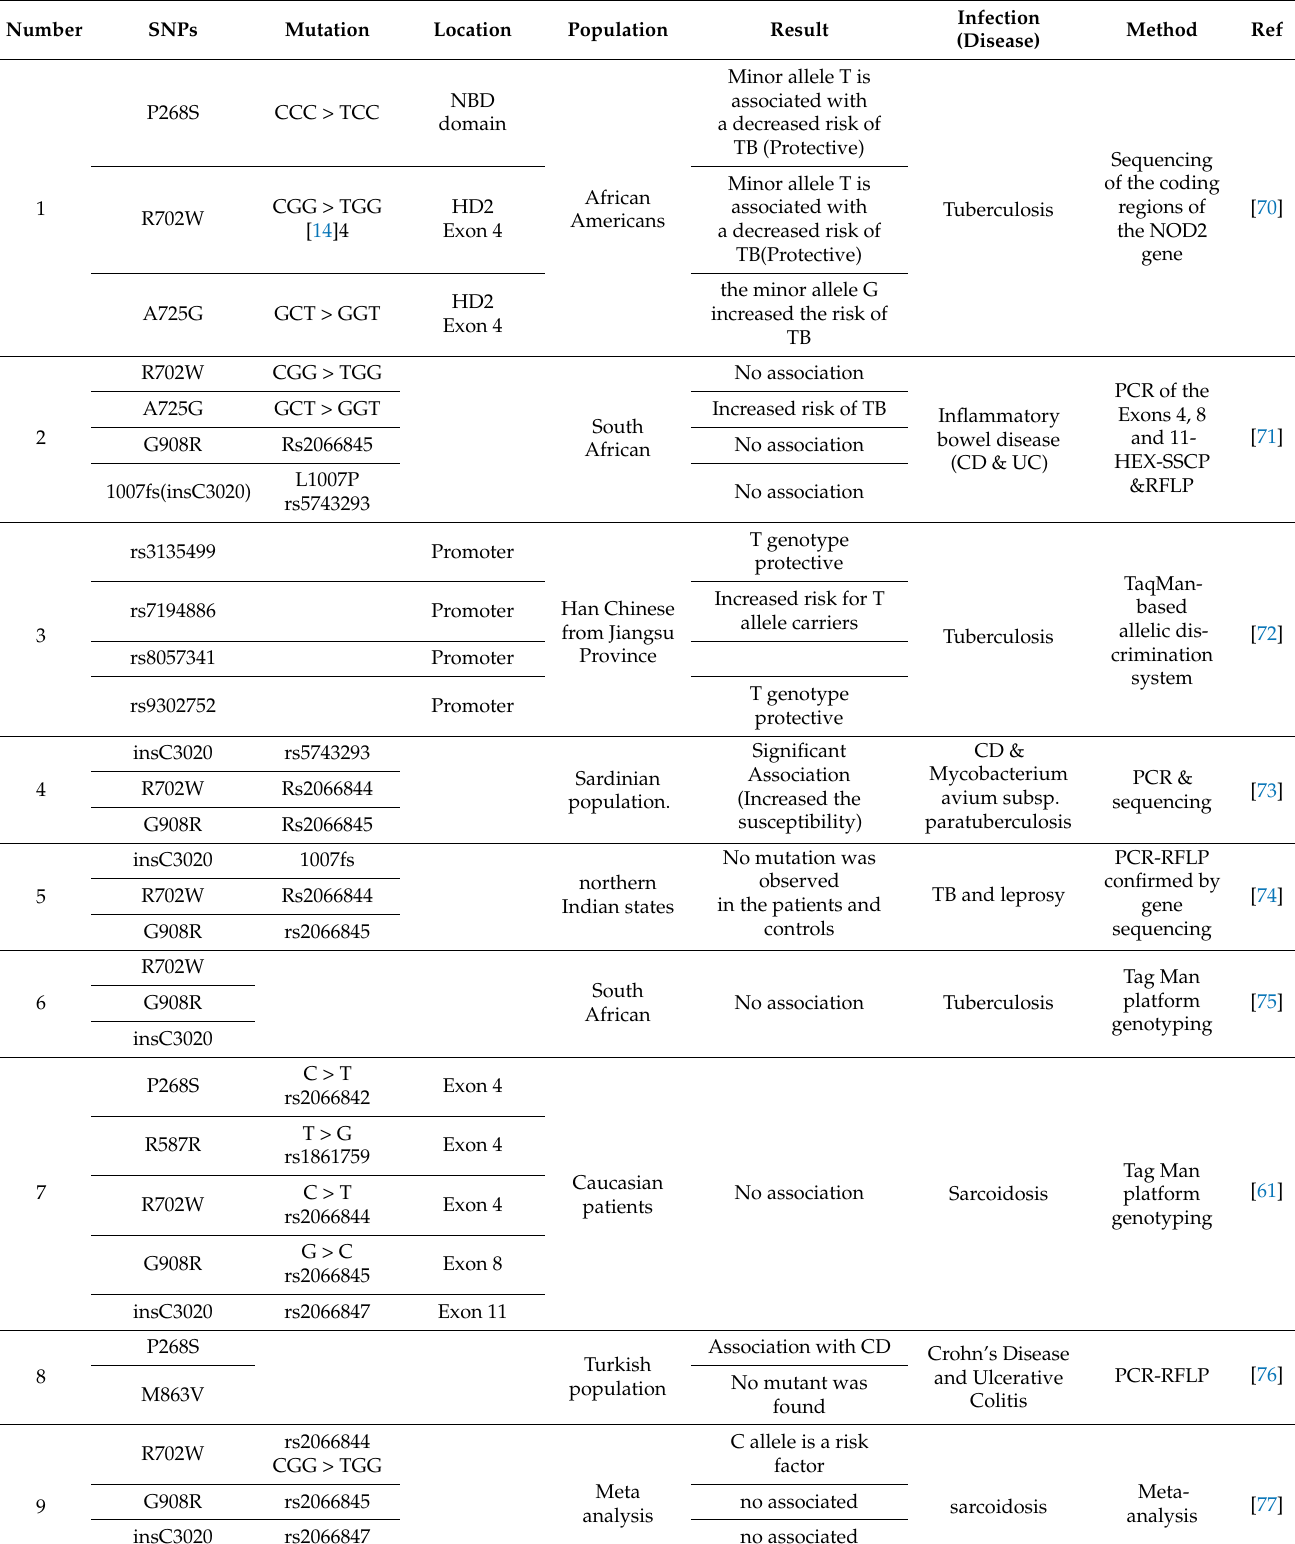
Table 1. Some of the previous studies regarding the common polymorphisms in NOD2 gene and the associated